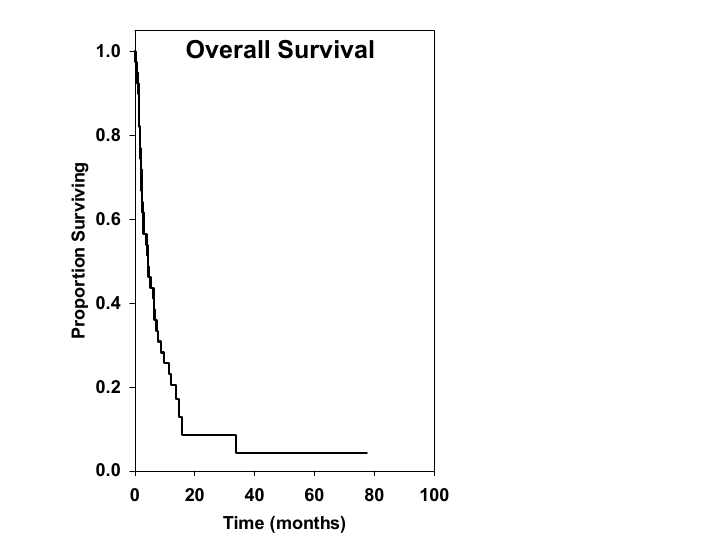
Figure 1. Overall survival of all patients with brainstem metastasis treated with Gamma Knife radiosurgery (GKRS) ( n =